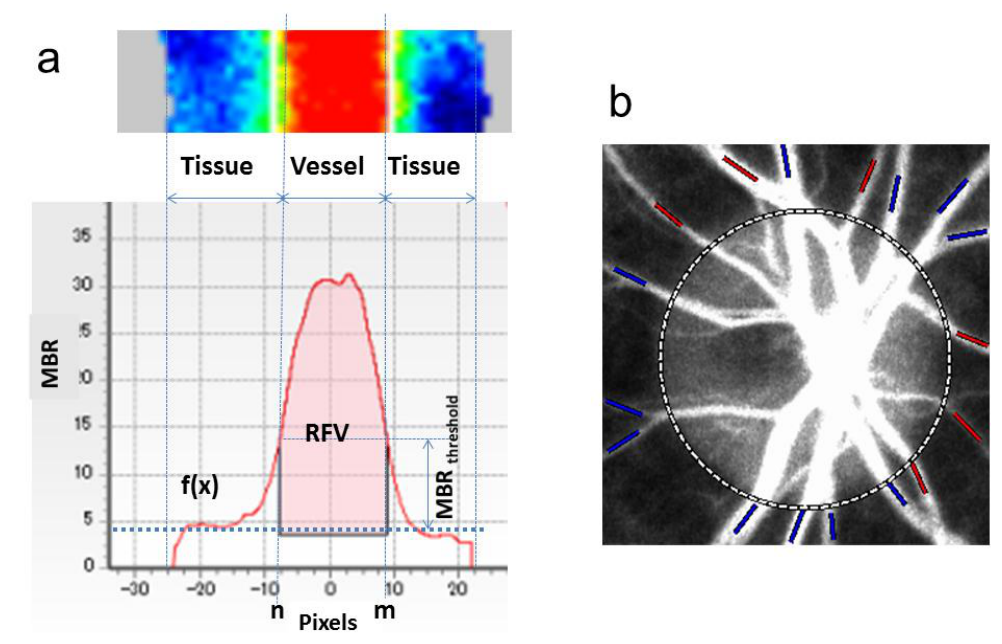
is the threshold